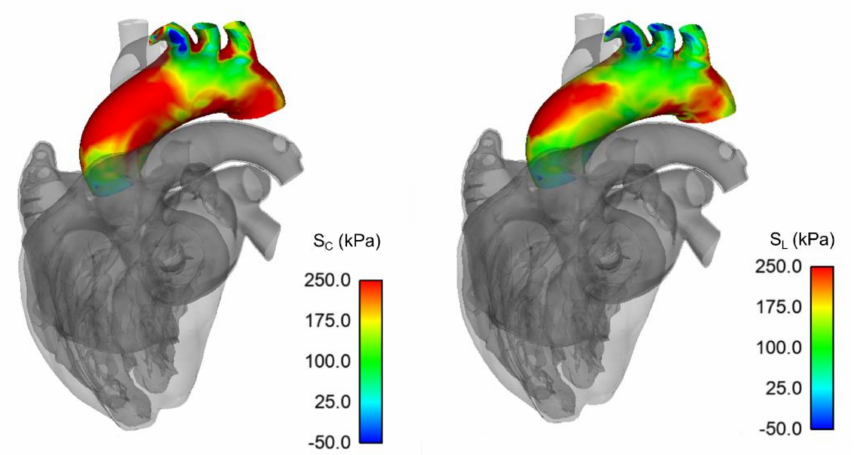
Figure 4. Circumferential ( S C ) and longitudinal stress ( S L ) map during systolic peak for unmodified LHHM healthy aorta.